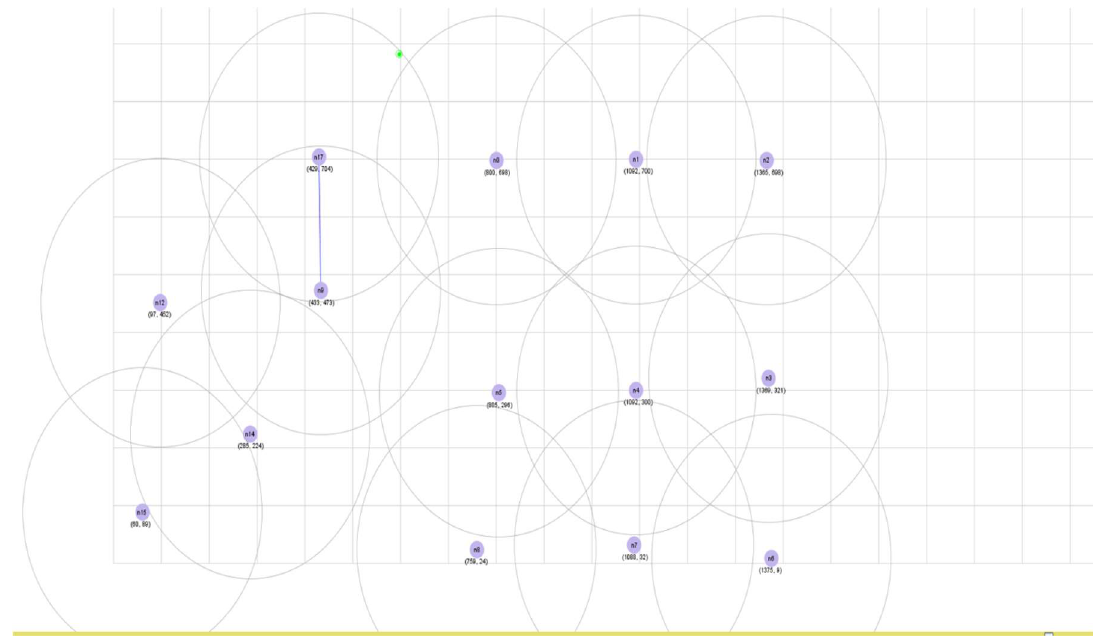
Figure 11. Microgrid communication wireless model.